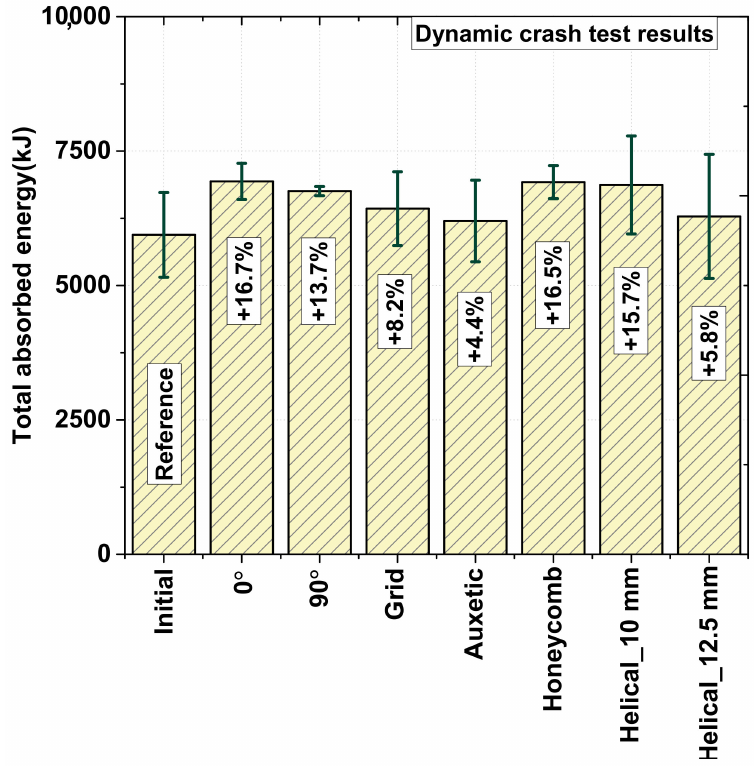
Figure 10. Energy absorption with dynamic crashing conditions at 40